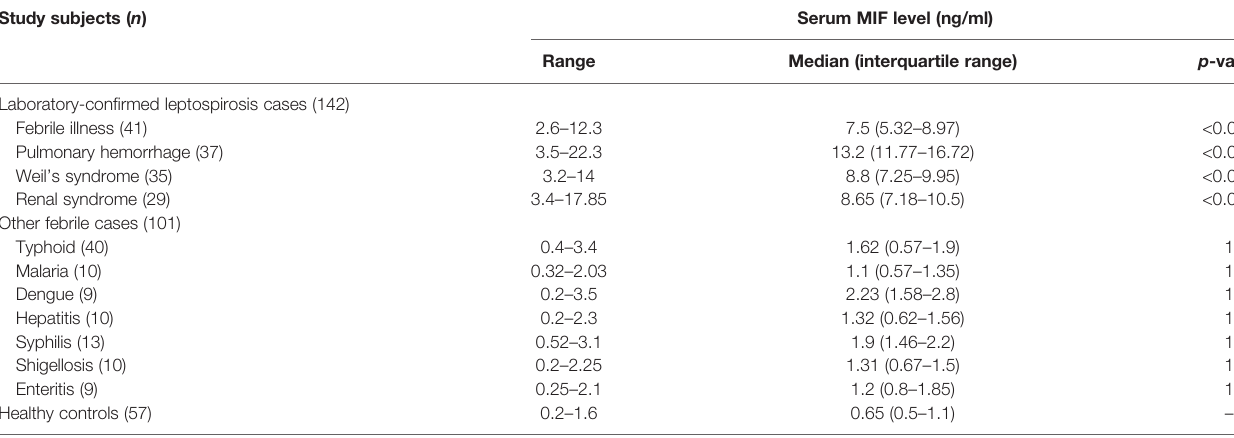
TABLE 3 | Serum macrophage migration inhibitory factor (MIF) levels in patients and healthy controls.